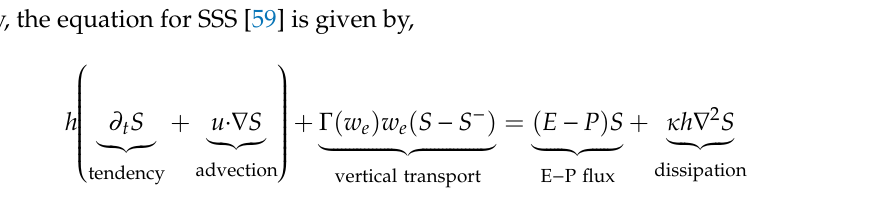
Figure 16. Sea Surface Temperature (SST) and Sea Surface Salinity (SSS) diagnoses. ( a ) SST induced by the advection. ( b ) SST induced by the Ekman downwelling. ( c ) SST induced by the sum of the horizontal and vertical processes. ( d ) SSS induced by the advection. ( e ) SSS induced by the Ekman upwelling. ( f ) SSS induced by the sum of the horizontal and vertical processes.